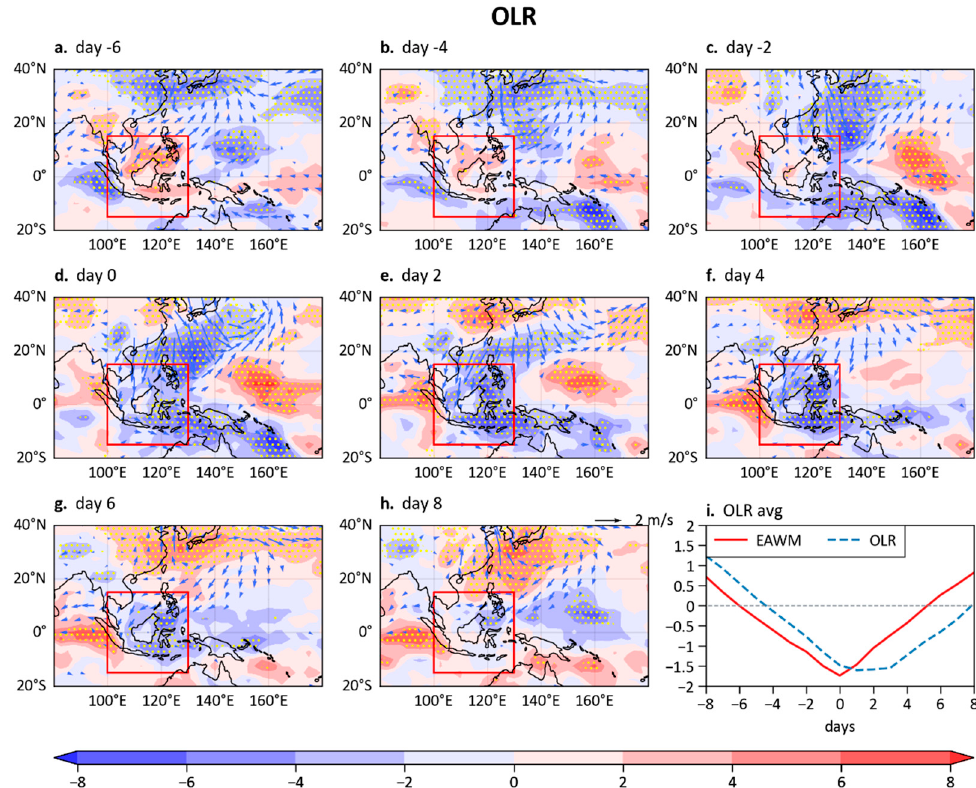
Figure 3. ( a – h ) Composite anomalies of 1000 hPa winds (vector, m s − 1 ) and OLR (color, W m − 2 ) at days − 6 to 8 with an interval of 2 days during the strong EAWM events. Stripping regions indicate the OLR anomalies exceed the 95% confidence level. Only meridional or zonal wind anomalies that exceed the 90% confidence level are plotted. ( i ) Temporal evolutions of the composite EAWM index and area-averaged OLR anomaly (normalized) in the WTP region of (15 ◦ S–15 ◦ N, 100 ◦ –130 ◦ E, red box) during the strong EAWM